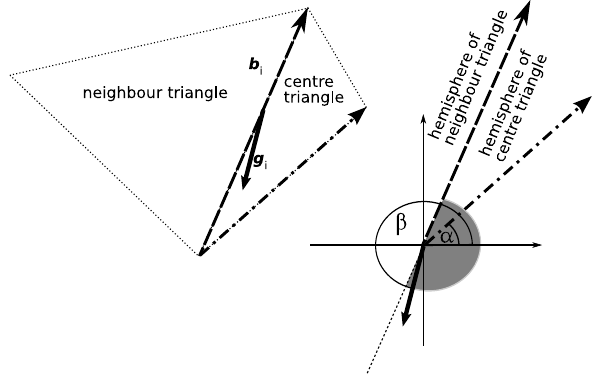
Fig. 3. Identification of the triangle to which the gradient points. The gray semicircle labels the side of the centre